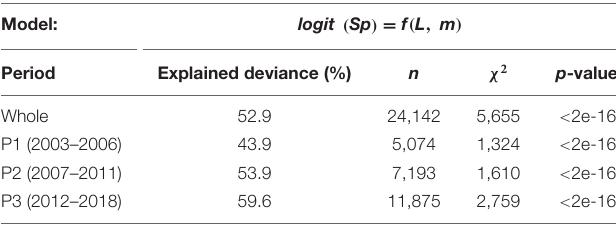
TABLE 2 | Summary description of fitted GAMs to sardine spawning probabilities (Sp) for the whole period and for the three periods identified in Véron et al. (2020).